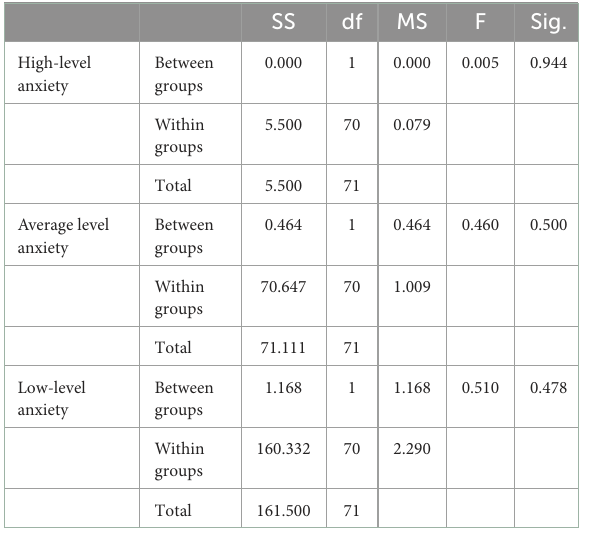
TABLE 2 One-way ANOVA results based anxiety levels in comparison to gender.